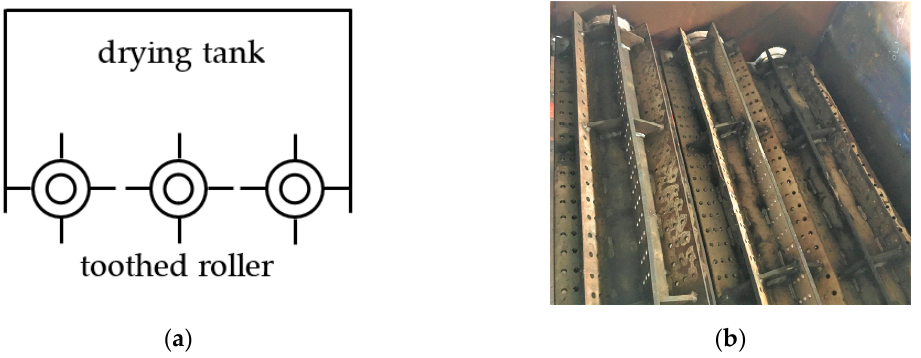
Figure 5. Apparatus for discharging experiment: ( a ) Conceptual scheme; ( b ) Real apparatus.